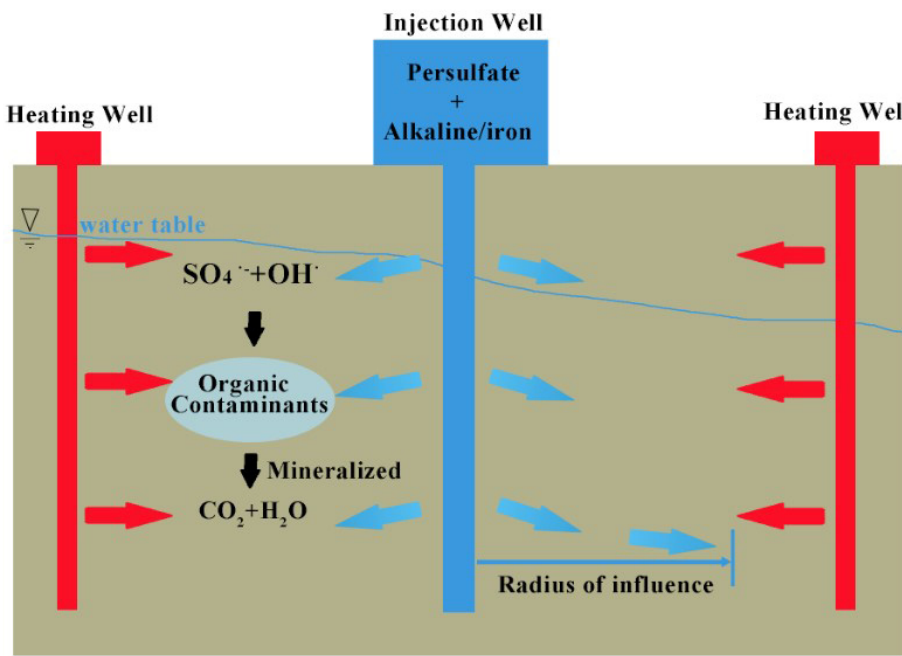
Figure 1. The application mechanism of ISCO using